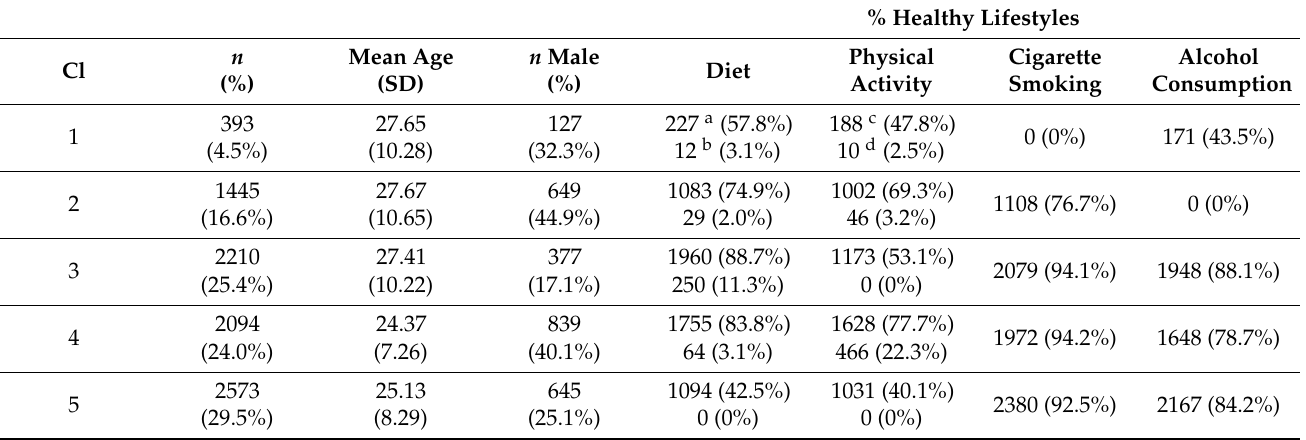
Table 4. Sociodemographic description and adequateness of lifestyle for the clusters identified. % Healthy